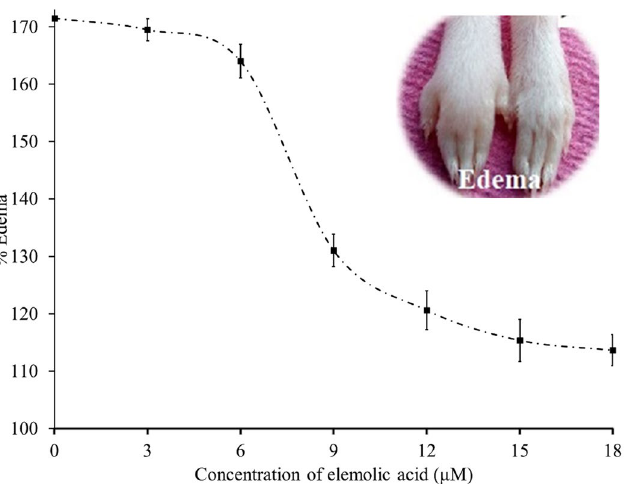
Figure 11. Neutralization of edema inducing activity of GIIA by elemolic acid. GIIA (5 µg) was pre-incubated with indicated concentration of elemolic acid (3 to 18 µM) for 30 min and injected into the right footpad of the hind limb of mice and the respective left footpad received vehicle (saline). After 45 min, mice were euthanized, and their legs were removed at the ankle joints and weighed separately. The edema ratio was calculated. The data are expressed in mean ± standard deviation (n =